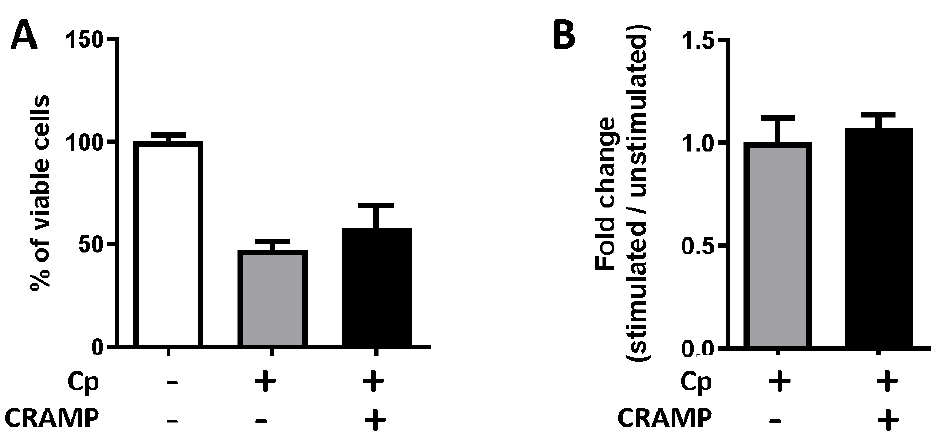
Figure 4. Stimulation of enterocytes by CRAMP does not modify their permissiveness to C. parvum infection. ( A ) mICcl2 cells were cultured to confluence and were stimulated or not with 100 ng / mL of CRAMP for 24 h, washed and infected or not by Cryptosporidium parvum (MOI 5) for an additional 24 h. Cell viability was analyzed with MTT test ( A ) and infection rates were analyzed by measuring RNA 18S expression by qRT-PCR ( B ). These results are representative of three independent experiments with similar results.